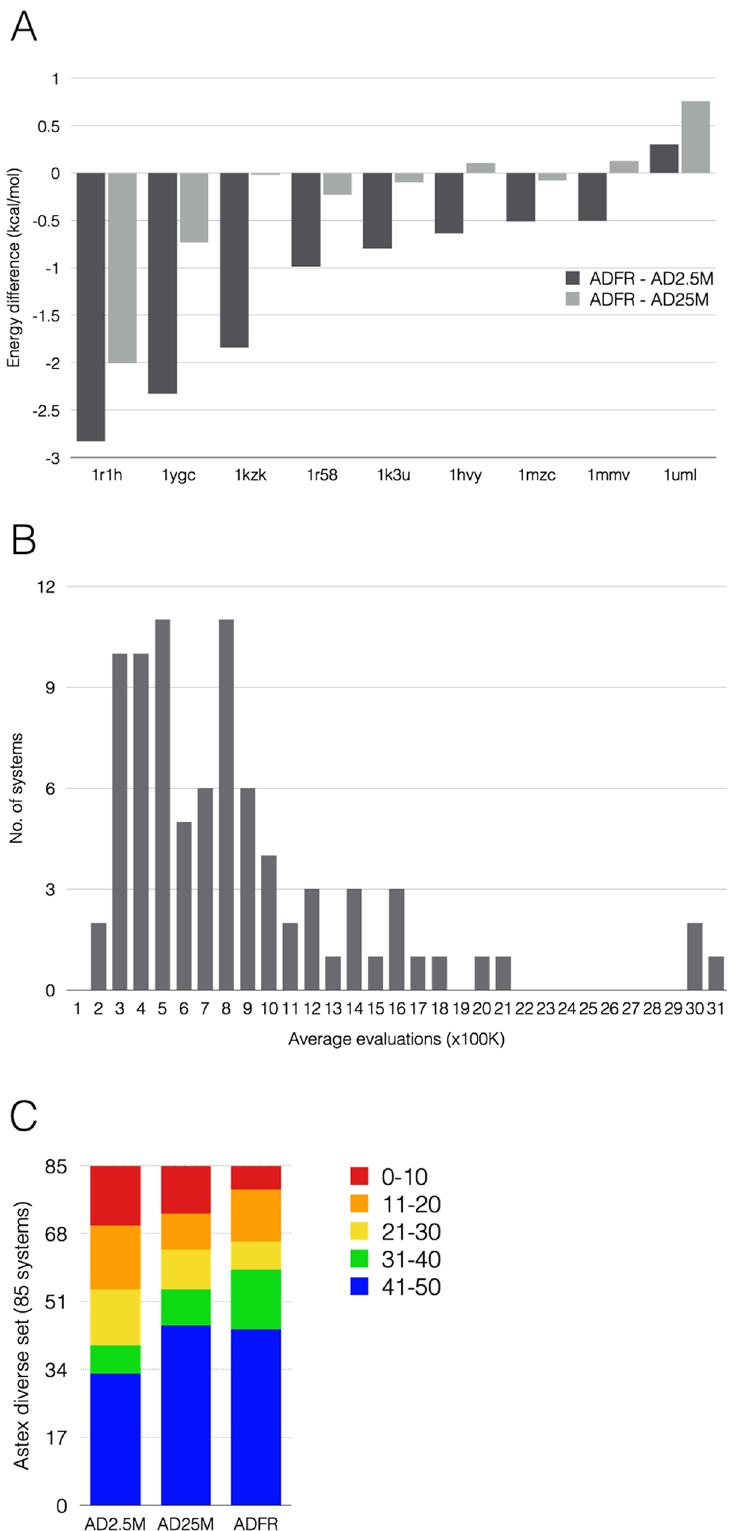
Fig 5. Astex Diverse Set re-docking. A) The bars depict the energy differences between lowest energy solution found by ADFR and AD 2.5M (dark), and ADFR and AD 25M (light). Negative values indicate a